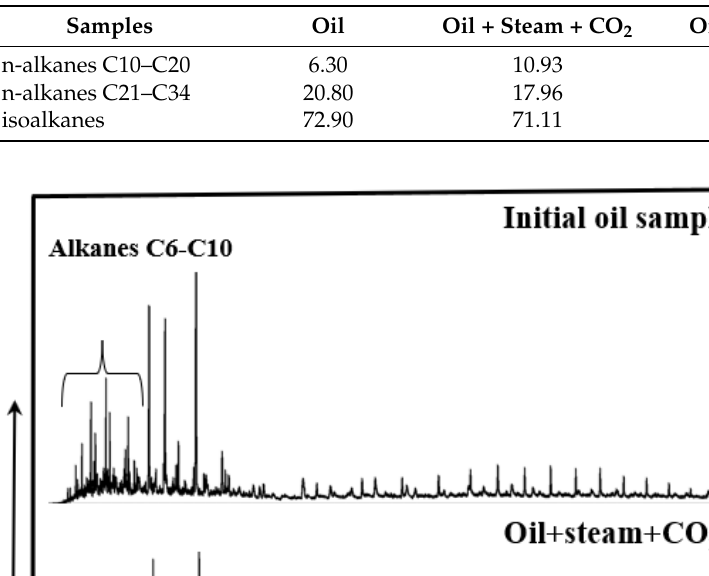
Table 2. The relative content of n-alkanes in the composition of the saturates of the oil, before and after the noncatalytic and catalytic hydrothermal processes.